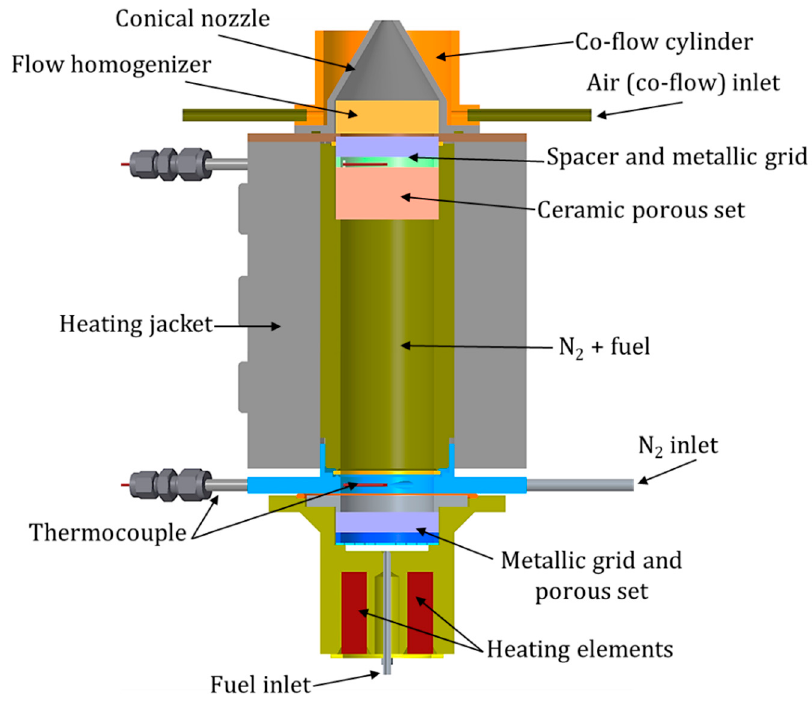
Figure 1. Schematic design of the laminar burner for diesel vaporization and combustion.